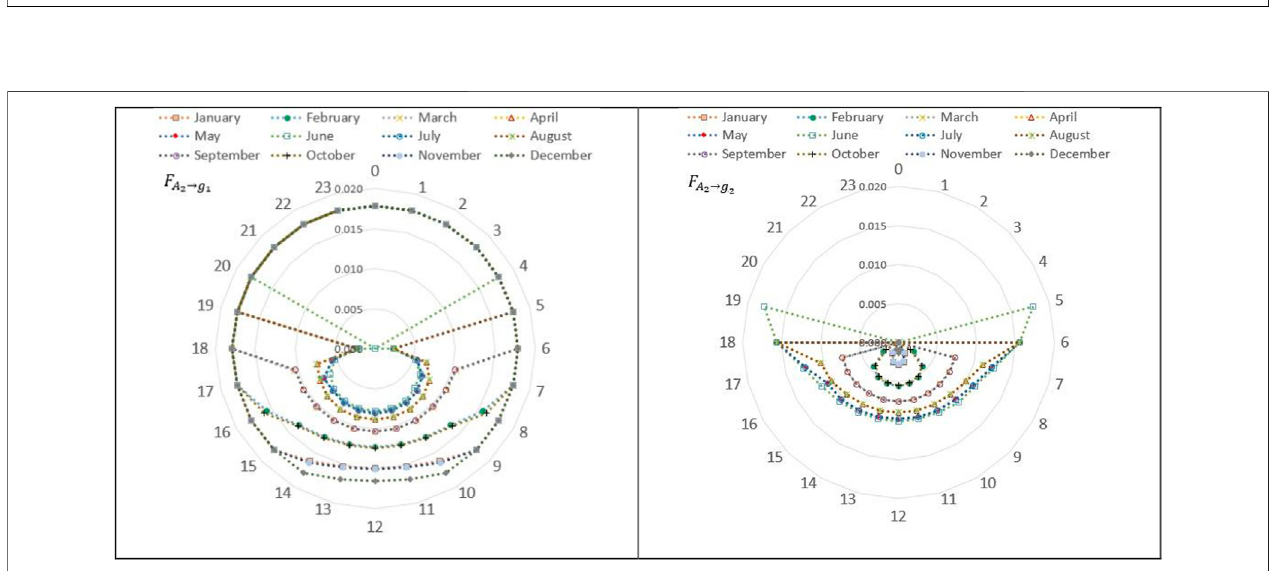
FIGURE 14 | Aspect ratio of the shaded and unshaded zones Z 1 L × W (cid:2) 200 × 6 m , and. d (cid:2) 9 . 0 m